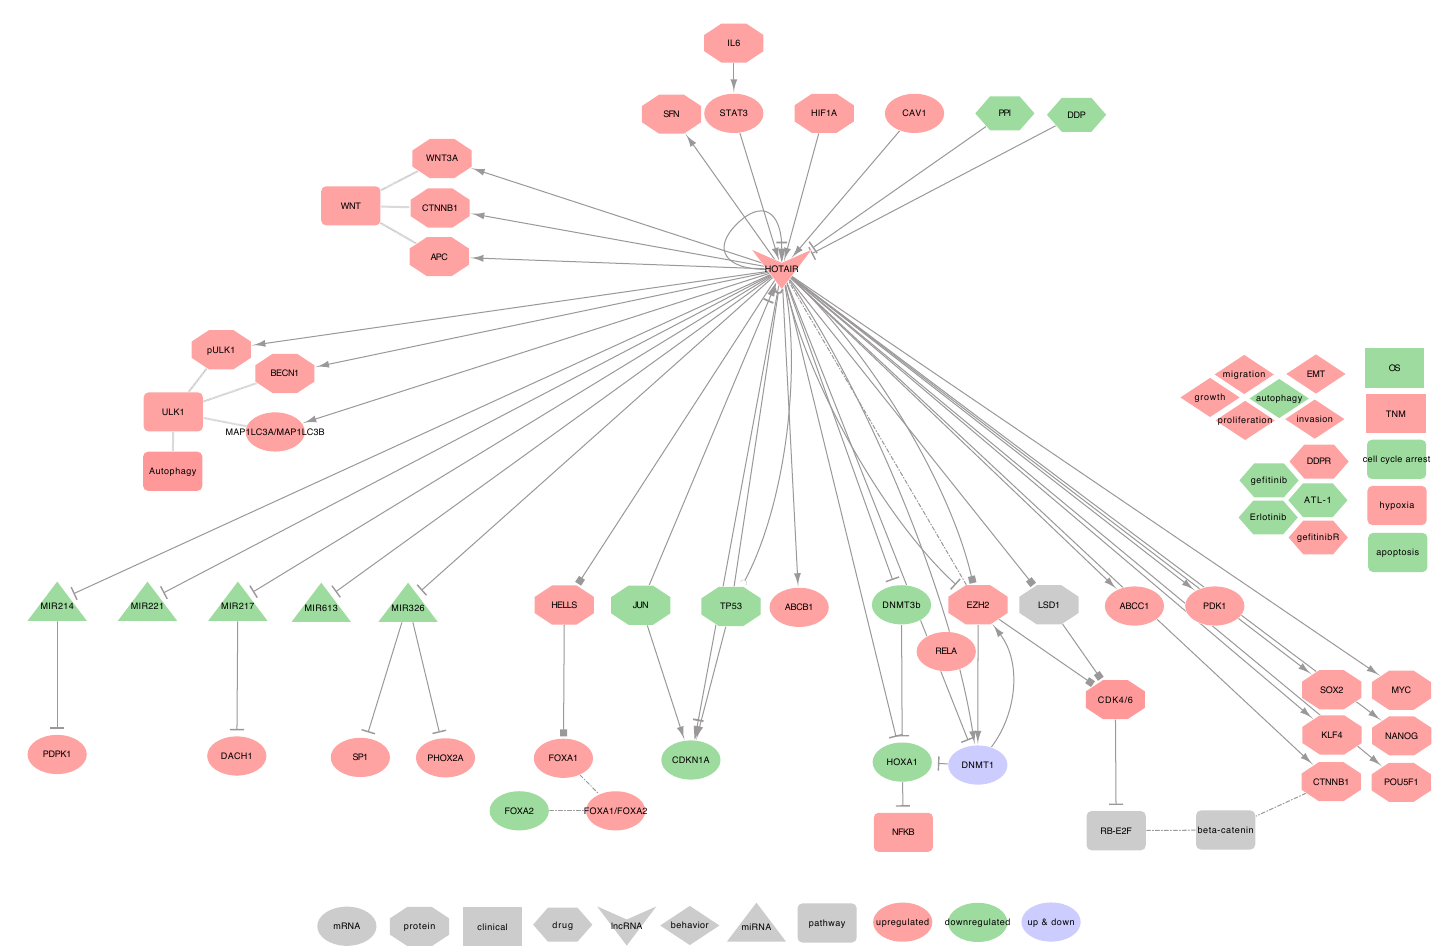
Figure 11. HOTAIR in lung cancers: A network of lncRNA-miRNA-Protein interactions. Upregulated molecules are in green. Downregulated molecules are in red. Up or down-regulated molecules are in purple. Shape definitions are in grey. Gray arrows target the activated molecules. T-ended lines target the inhibited molecules. Square-ended lines represent a binding between molecules. Dashed-dot lines represent an association with unknown